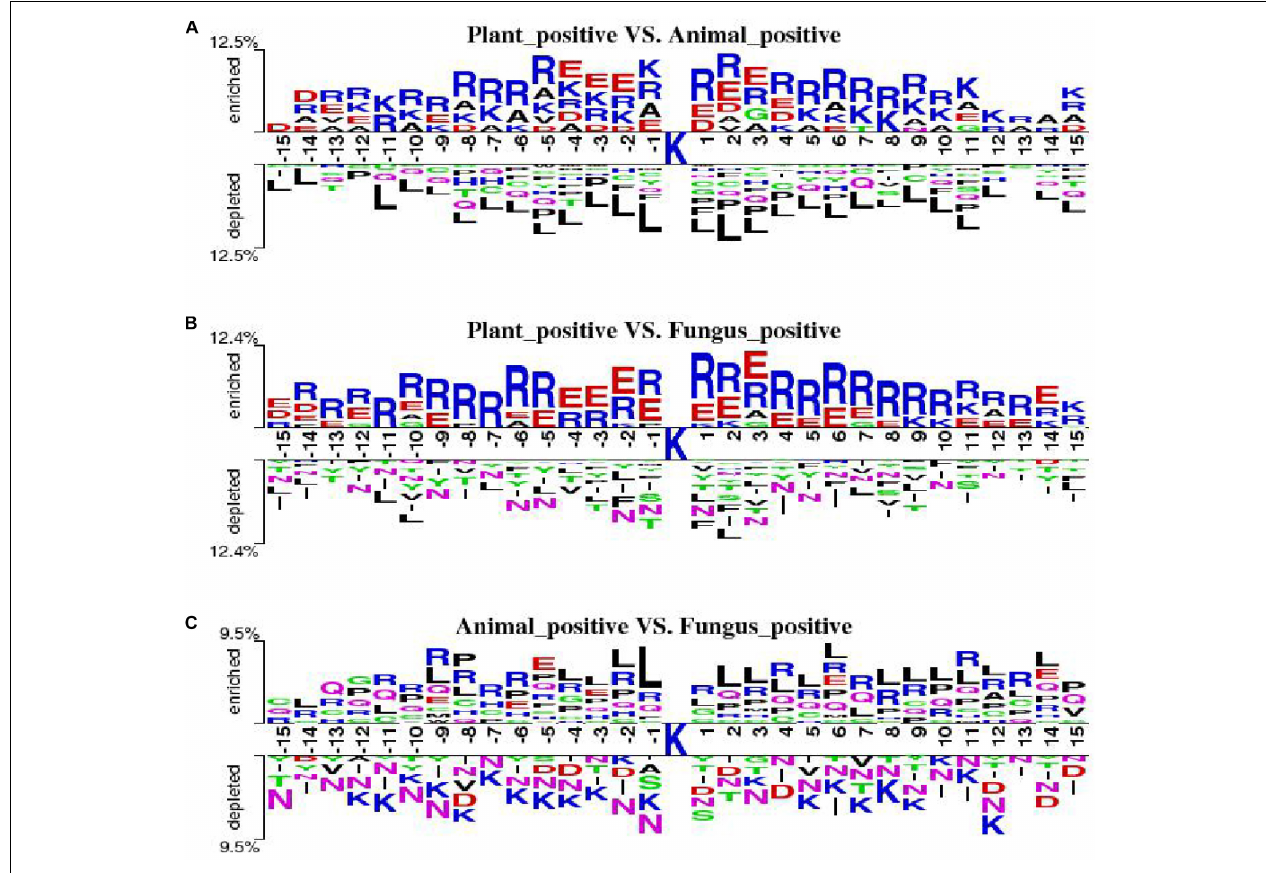
FIGURE 7 | Comparison of the Two Sample Logo of three species. (A) Two Sample Logo of positive samples between plants and animals. (B) Two Sample Logo of positive samples between plants and fungi. (C) Two Sample Logo of positive samples between animals and fungi.